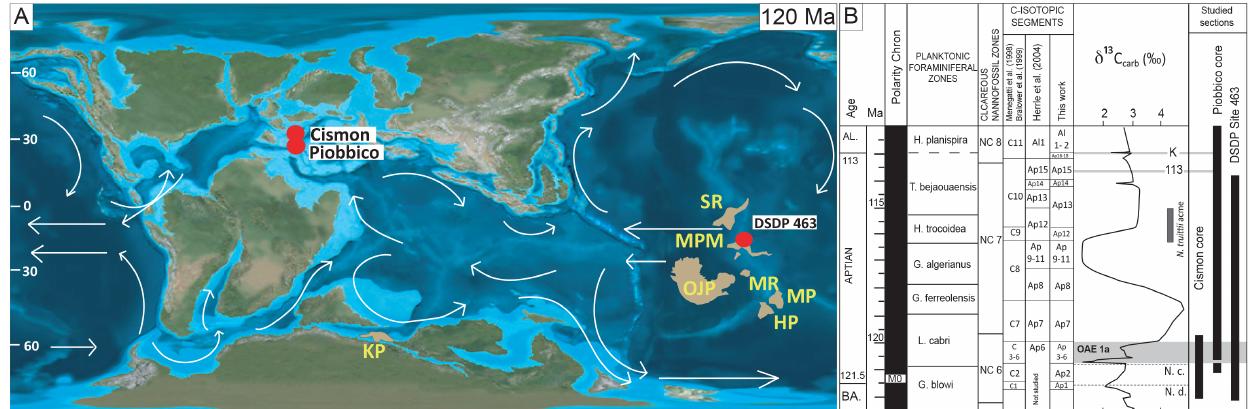
Figure 1. (a) Location map of studied sites at 120Ma (modified after Erba et al., 2015). OJP: Ontong Java Plateau; KP: Kerguelen Plateau; SR: Shatsky Rise; MPM: Mid-Pacific Mountains; MR: Magellan Rise; MP: Manihiki Plateau; HP: Hikurangi Plateau. (b) Stratigraphic ranges of the studied sections. Latest Barremian to earliest Albian chronologic framework is from Erba et al. (2015). Numerical ages are based on the timescale of Malinverno et al. (2012). Codes for C-isotope segments after Menegatti et al. (1998), Bralower et al. (1999), Herrle et al. (2004) and this work are reported. K: Niveau Kilian; 113: 113 Level; N.c.: Nannoconid crisis; N.d.: Nannoconid